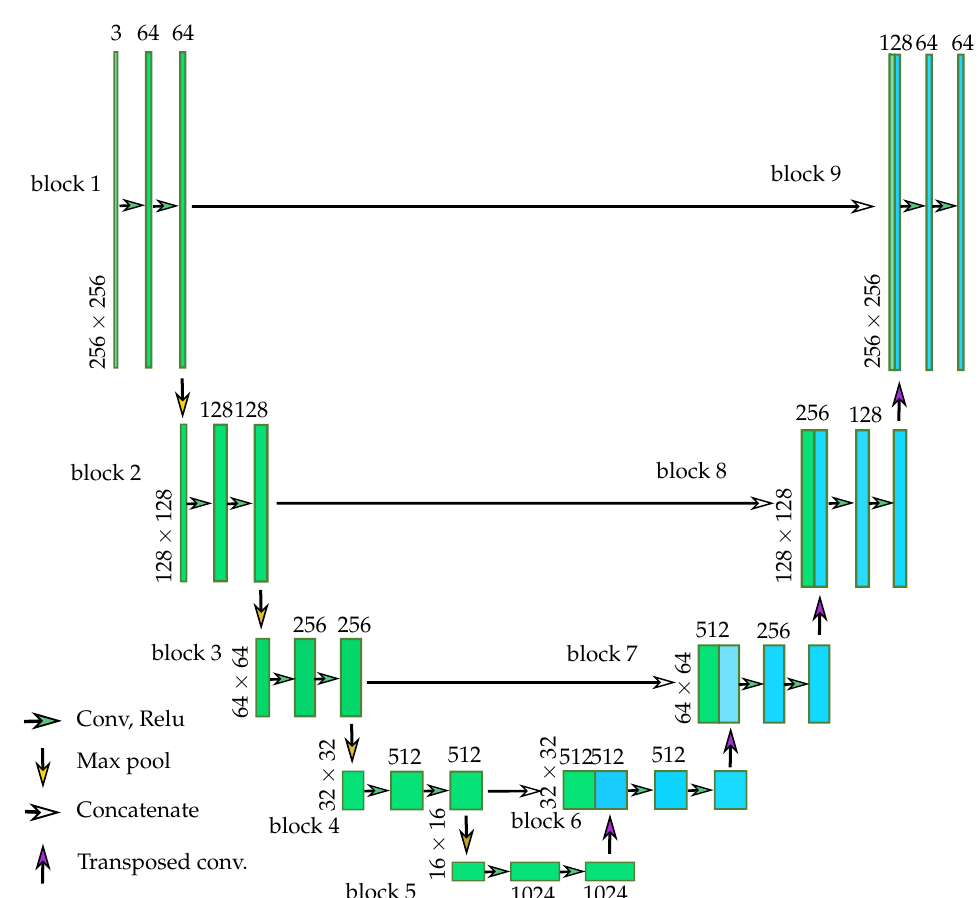
Figure 3. The architecture of the U-Net used in the proposed method. The network has 3 convolu- tional layers followed by 2 fully connected